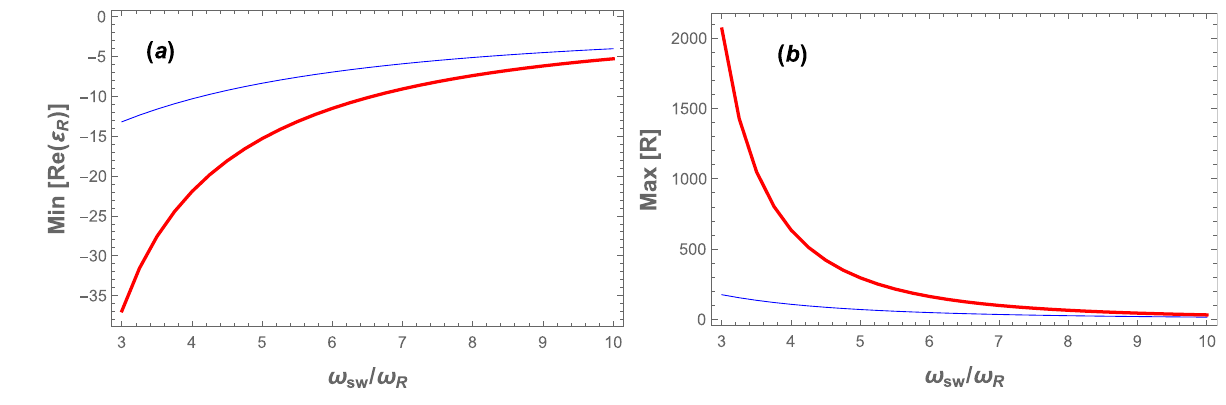
Figure 5. (Color online) ( a ) The minimum value of the real part of the reflected field amplitude, ( b ) the maximum value of the cavity power reflection coefficient at the signal frequency versus ω sw /ω R for two different values of the coupling laser pumping rate: | ε c | = 0.10 κ (the blue thin curve) and | ε c | = 0.15 κ (the red thick curve). The other parameters are the same as those of Fig.